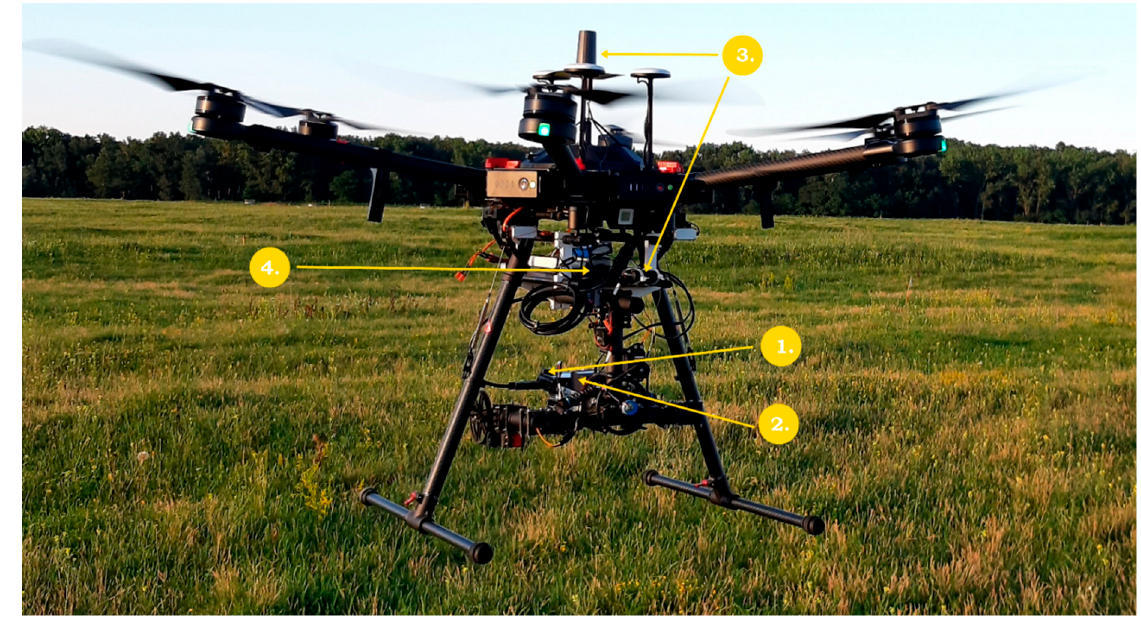
Figure 1. Picture of the DJI M600 UAV and the equipment mounted on it. The numbers and the arrows indicate the different parts of the imaging system. 1: Sony a6000 RGB camera, 2: Optris PI 640 thermal camera, 3: Emlid Reach M2 GNSS receiver and its antenna, 4: Raspberry 3B single-board